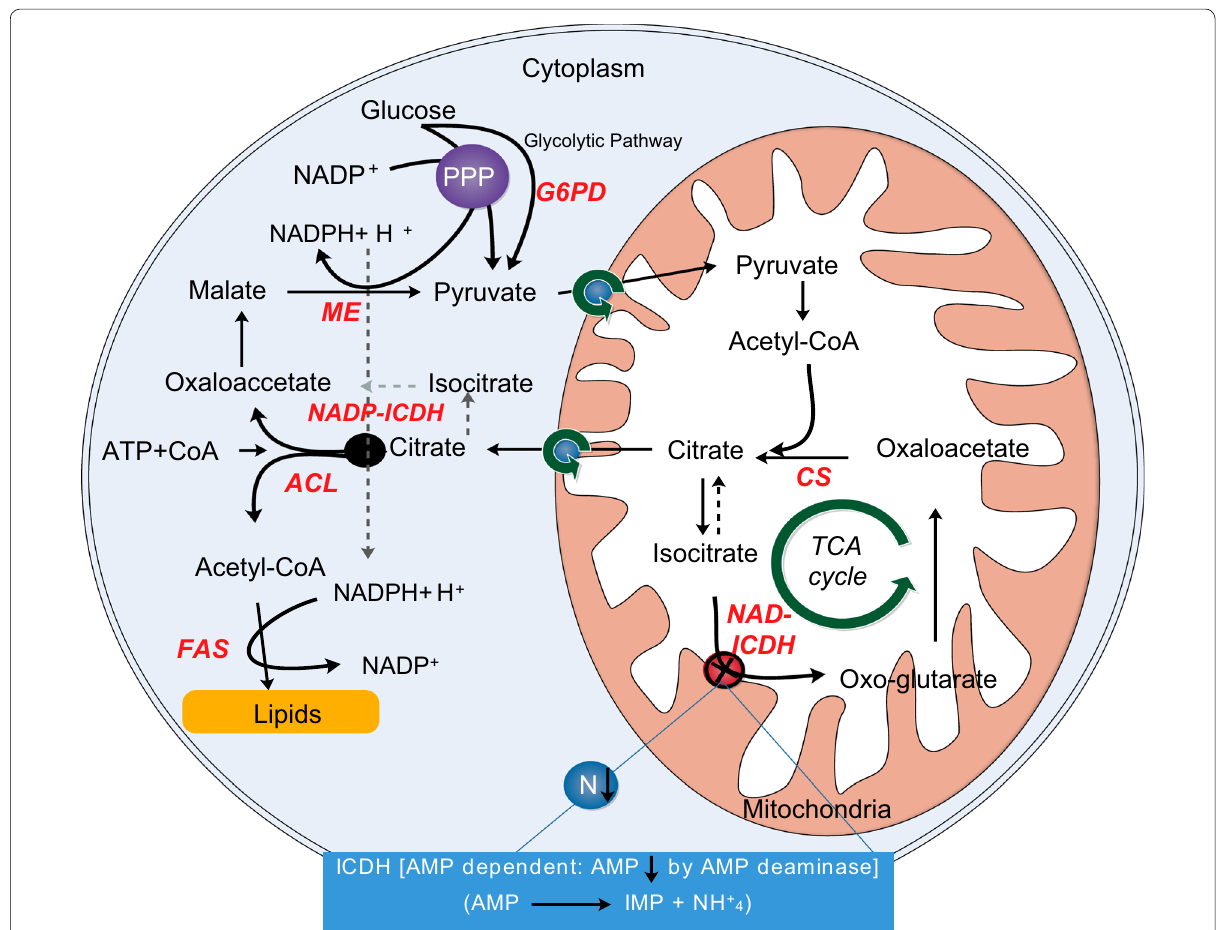
Fig. 6 Metabolic pathway of lipid accumulation in oleaginous microorganisms and related key enzymes. G6PD glucose-6-phosphate dehydro- genase, CS citrate synthase, NAD + -ICDH NAD dependent isocitrate dehydrogenase, NADP + -ICDH NADP dependent isocitrate dehydrogenase, ACL ATP-citrate lyase, ME malic enzyme, FAS fatty acid synthase, PPP pentose phosphate pathway, AMP adenosine monophosphate, IMP inosine